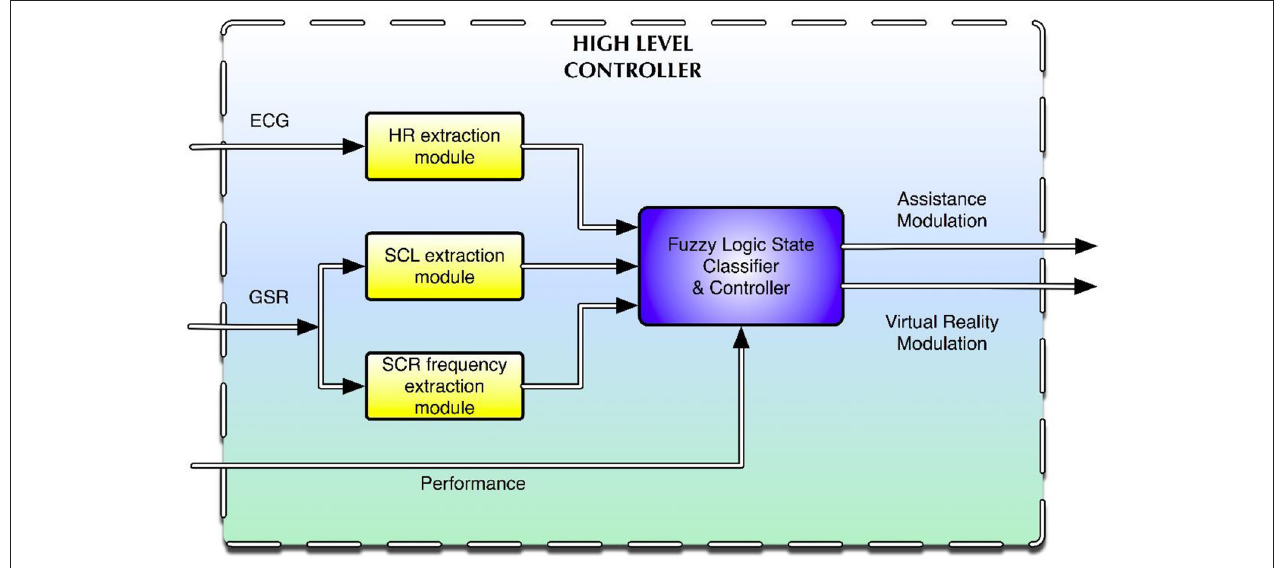
FIGURE 2 | High-level controller driving the interaction between the subject and the multimodal